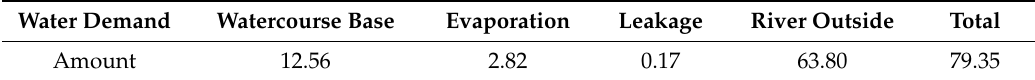
Table 5. Ecological water demand of the study area (10 6 m 3 ).